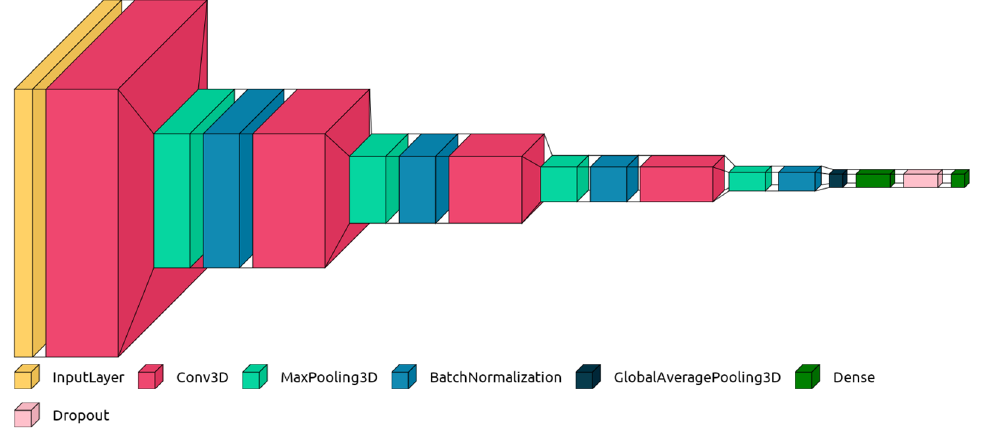
Figure 3. 3D-CNN topology sketch.